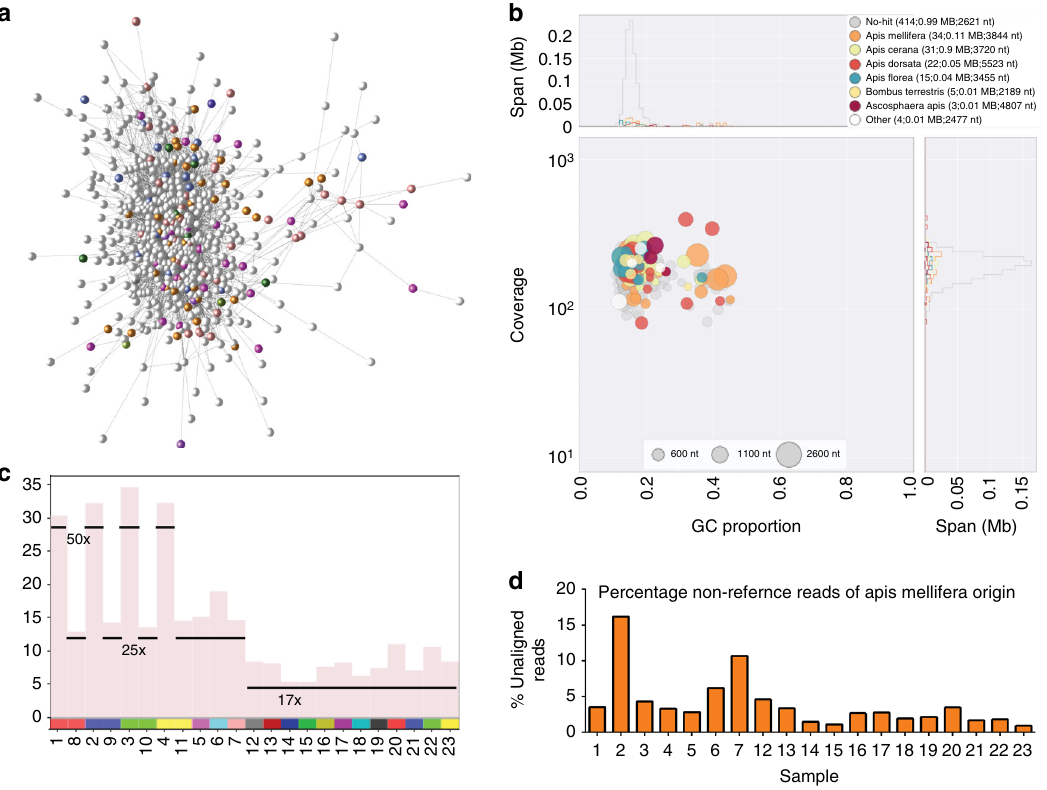
Fig. 4 Putative Apis mellifera contigs. a A network component comprised of contigs which did not match the reference bee genome and were unassigned (white) or matched a non-reference species of bee (coloured). b Blobplot of these contigs (as in Fig. 2). c Mean base coverage per contig ( y -axis) for each sample ( x -axis) for the contigs in A. The sequencing depth (reference genome coverage) per sample is shown, showing that the number of reads mapping to these contigs is in direct proportion to the depth of sequencing. d A graph displaying the percentage of unaligned reads putatively identi fi ed as Apis mellifera from each